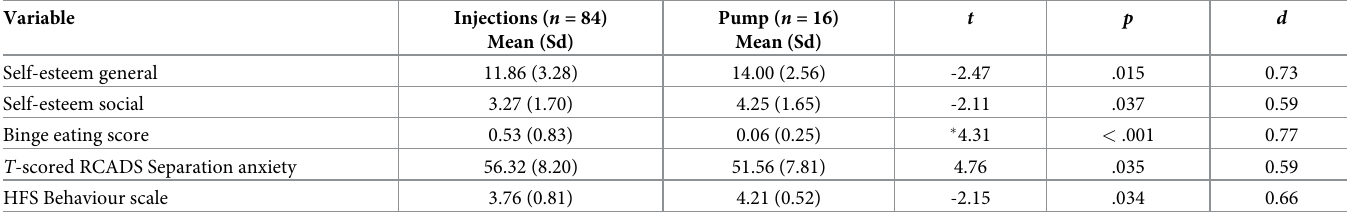
Table 6. Diabetes management differences on main